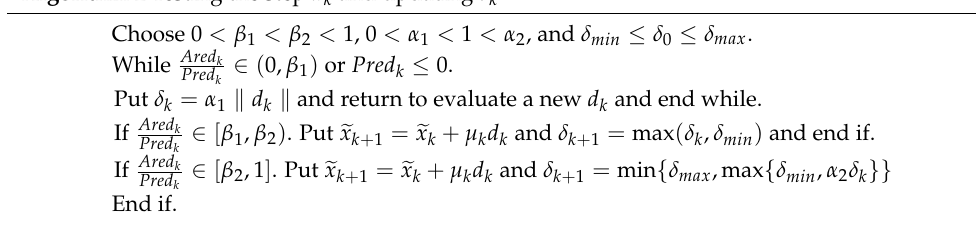
Algorithm 2 Testing the step d k and updating δ k